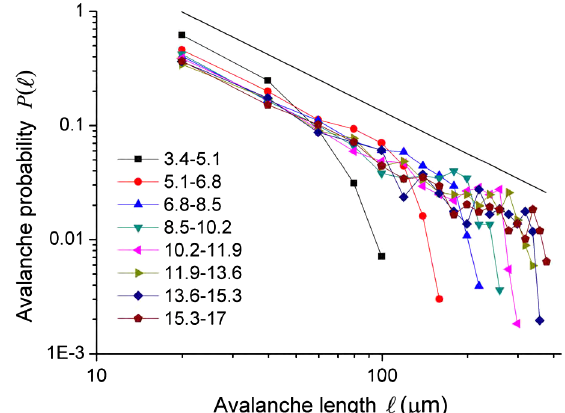
FIG. 5. Statistics of avalanche length, ‘ , observed while the applied field is ramped from zero to B a ¼ 17 mT in steps of (cid:1) B a ¼ 42 : 5 (cid:3) T . The curves correspond to the field intervals listed in the key (mT). The straight line with a slope of (cid:2) 1 : 3 is added as a guide to the eye.